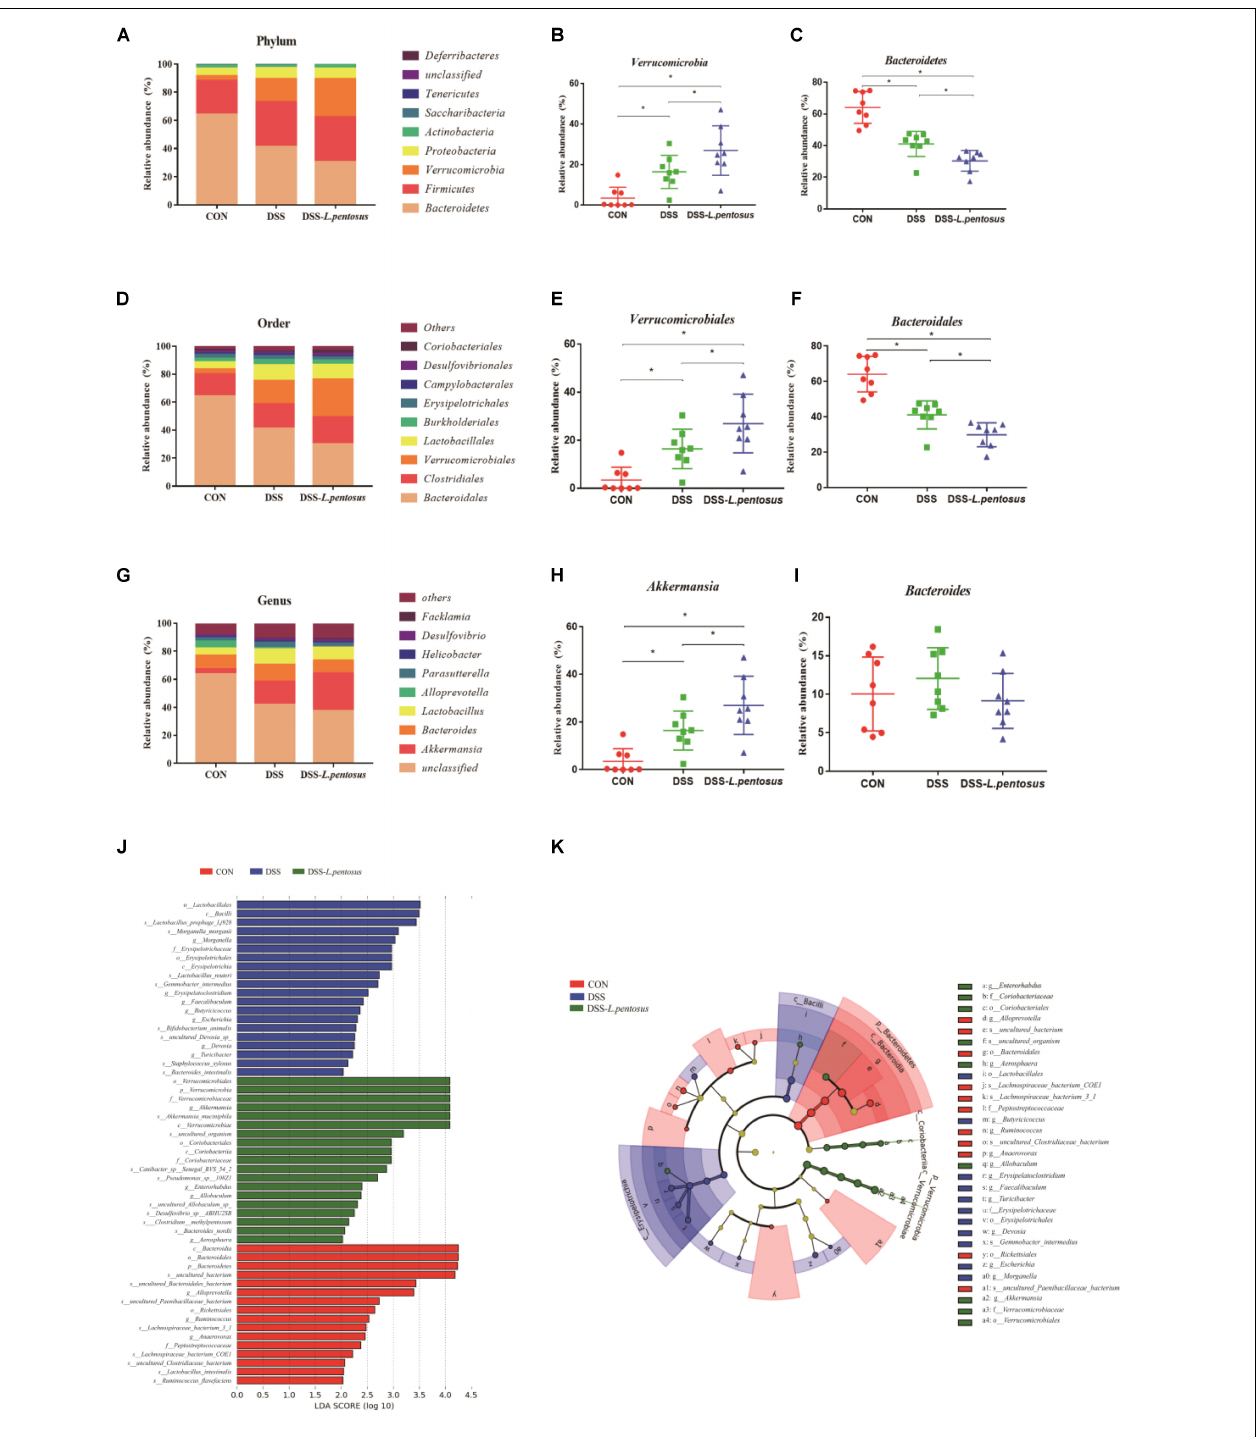
FIGURE 7 | Effects of different treatments on gut microbiota in mice. (A) Relative abundance of gut microbiota phyla; (B) percentage of Verrucomicrobia in each sample from the three groups; (C) percentage of Bacteroidetes in each sample from the three groups; (D) relative abundance of gut microbiota orders; (E) percentage of Verrucomicrobiales in each sample from the three groups; (F) percentage of Bacteroidales in each sample from the three groups; (G) relative abundance of gut microbiota genera; (H) percentage of Akkermansia in each sample from the three groups; (I) percentage of Bacteroides in each sample from the three groups. (J) LDA score, an LDA score greater than 4 was considered to indicate an important contributor to the model; (K) LEfSe taxonomic cladogram, with different colors indicating the enrichment of certain taxa in the control (red), DSS (blue), and DSS- L. pentosus (green) groups. Data are mean ± SD ( n = 8) and analyzed by one-way ANOVA. * p <